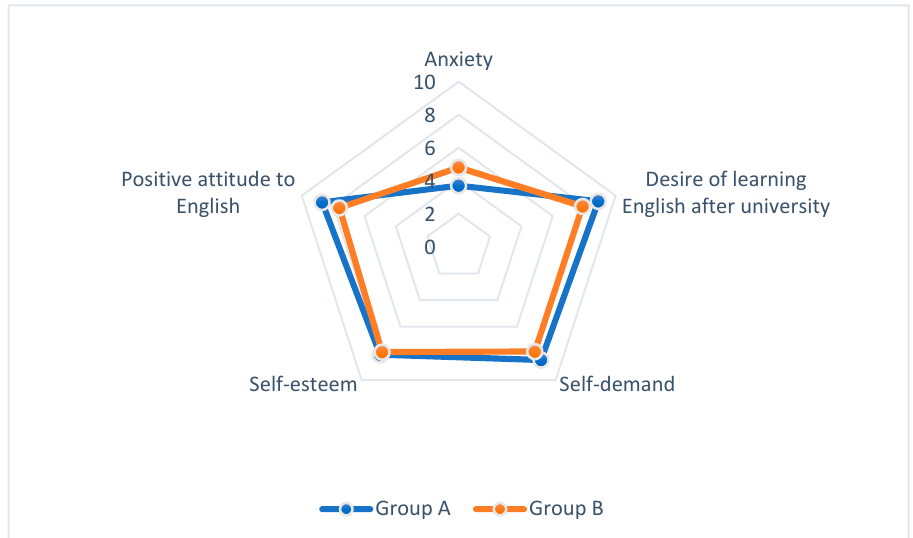
Figure 5. Results of students’ motivation survey.